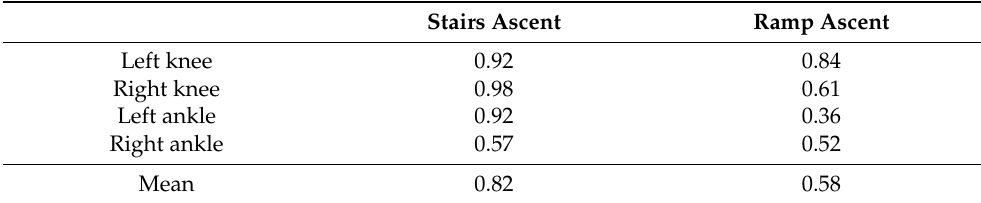
Table 4. The correlation value for each joint during stair and ramp ascent. Stairs Ascent Ramp